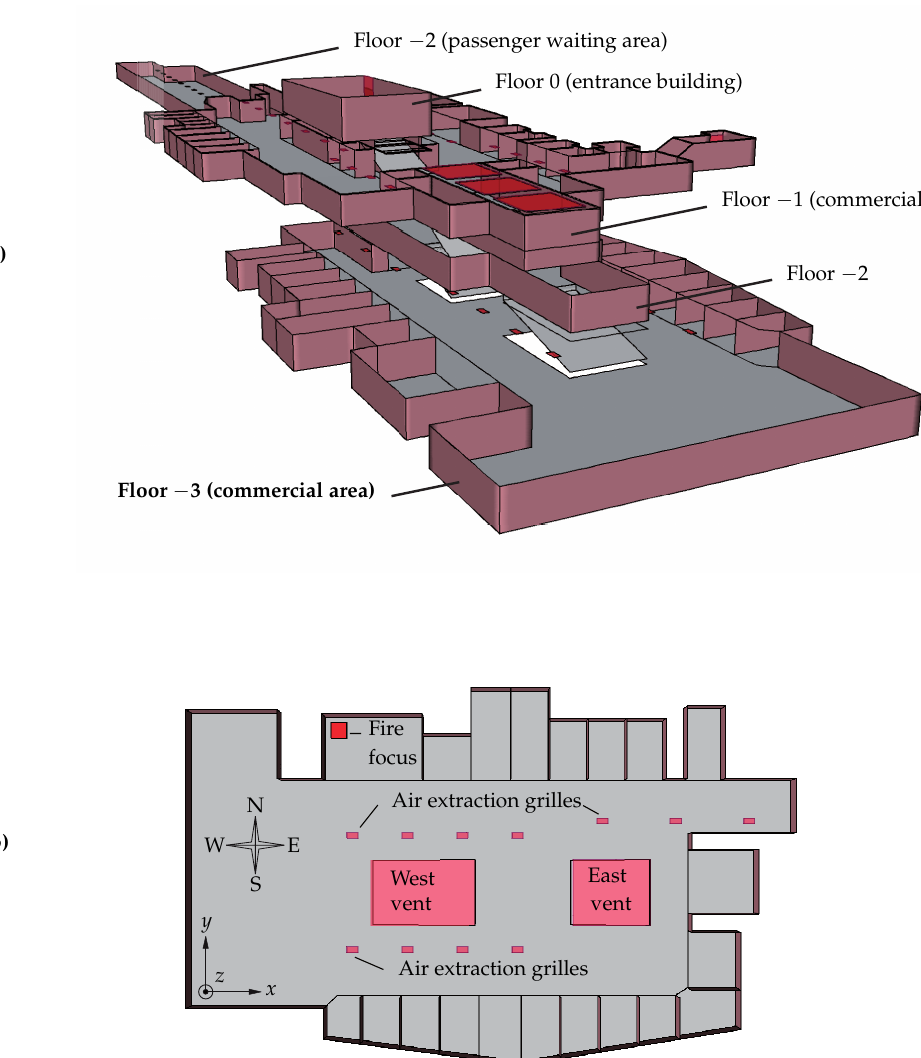
Figure 1. (a) Schematic view of the transportation station building (excluding platforms). (b) Top view of the shopping area where the fire originates (level -3): natural and forced ventilation systems, fire focus and reference system.